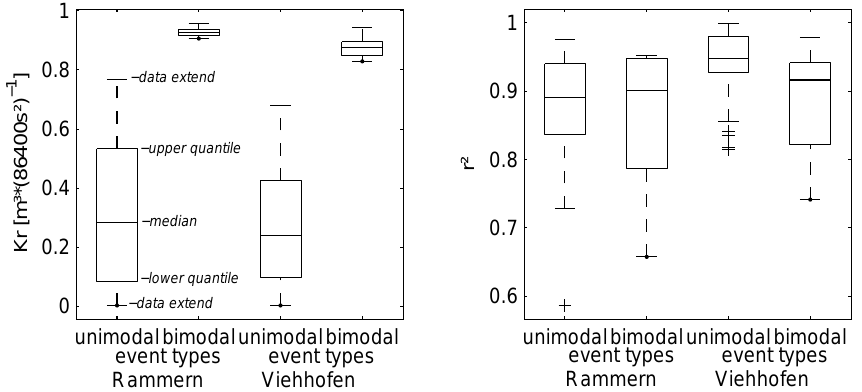
Fig. 10. Box plots of recession coefficients K t r (left) with goodness of curve fit r 2 (right) for the unimodal and bimodal event types at the small-catchment scale (gauge Rammern) and at the meso-scale (gauge Viehhofen).